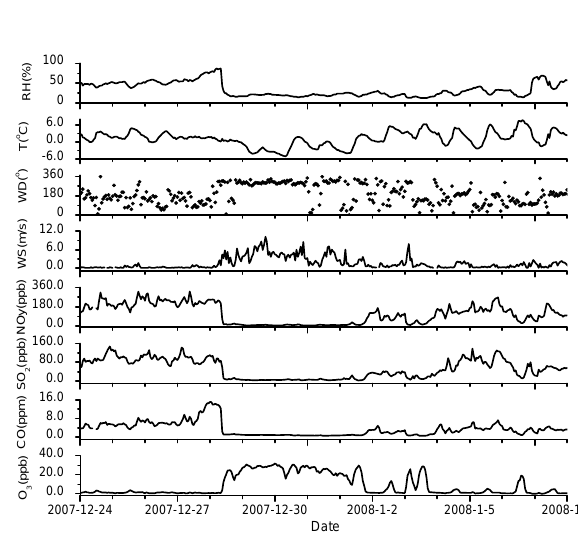
Fig. 6 A case for pollutants’ accumulation and dilution. From December 28, 2007 to Fig. 6. A case for pollutants’ accumulation and dilution. From January 1, 2008, the cold, fast-moving air masses, lasting about four days, brought higher 28 December 2007 to 1 January 2008, the cold, fast-moving air O 3 concentration and facilitated the dilution of local pollutants in Beijing. and facilitated the dilution of local pollutants in